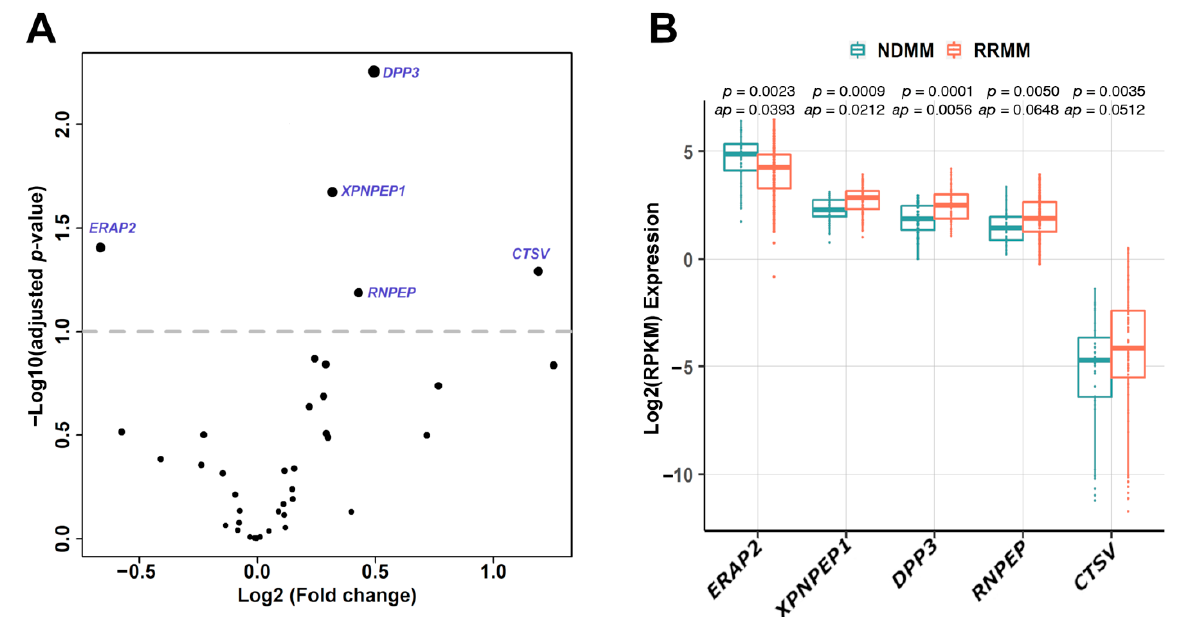
Figure 2. Aminopeptidase genes are differentially expressed in NDMM versus RRMM. ( A ) Five aminopeptidase genes ( ERAP2 , XPNPEP1 , DPP3 , RNPEP , CTSV ) were differentially expressed in RRMM ( n = 82) and NDMM ( n = 41) samples ( p < 0.05; adjusted p < 0.1) in the FIMM dataset. Differential gene expression between NDMM and RRMM was determined using the DESeq2 tool. ( B ) Among these five genes, only the expression level of ERAP2 was decreased in RRMM versus NDMM samples. NDMM: newly diagnosed multiple myeloma; RRMM: relapsed/refractory multiple myeloma; RPKM: reads per kilobase of transcript per million mapped reads; ap : adjusted p -value.